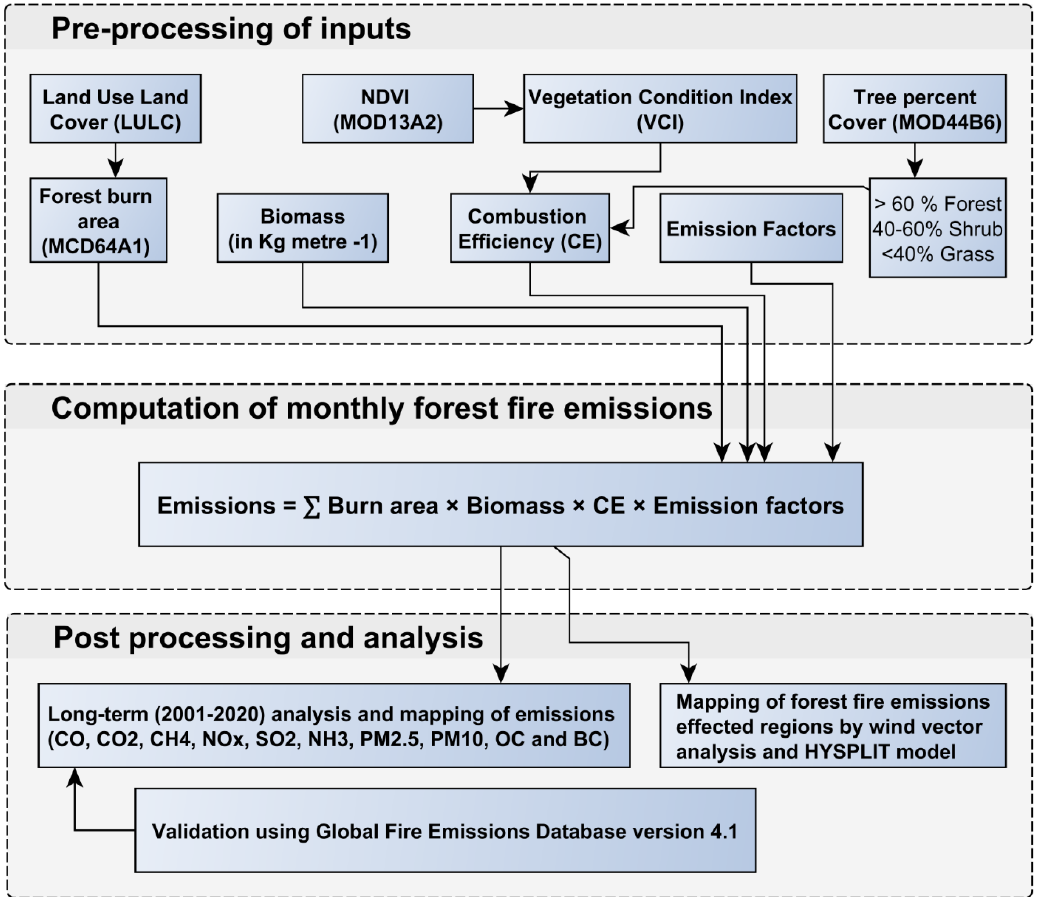
Figure 2. The methodology roadmap of forest fire emissions estimation and validation. Table 1. List of the datasets used to accomplish the pixel-based estimation of forest fire emissions.